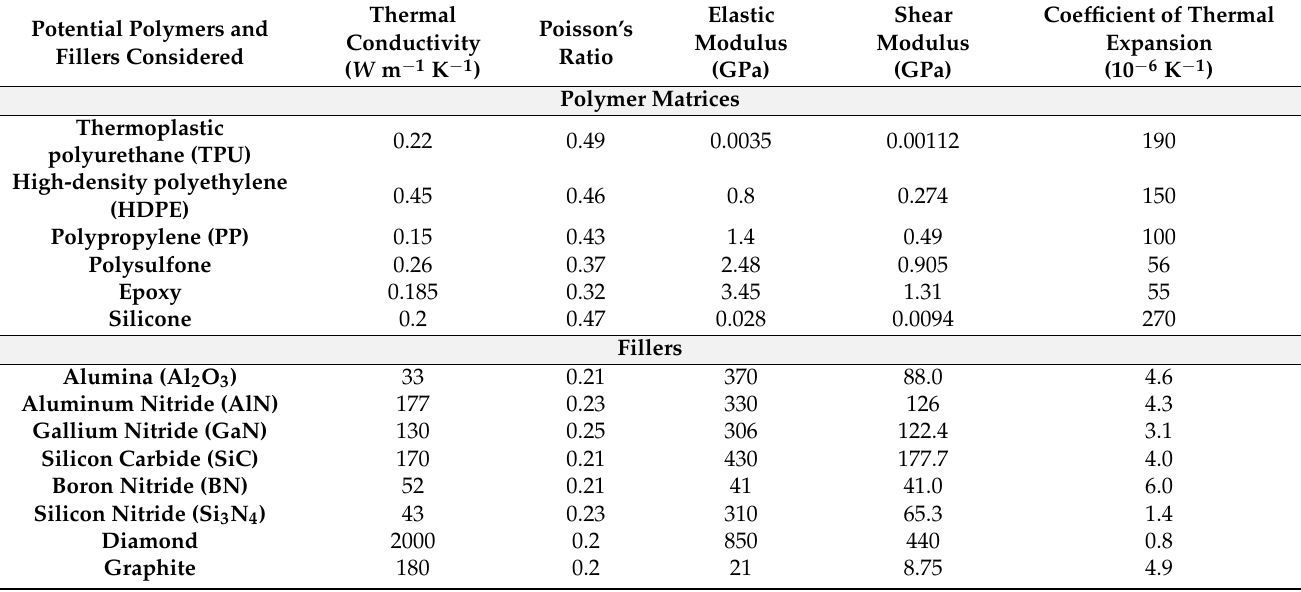
Table 1. Properties of potential matrices and fillers for thermal interface material